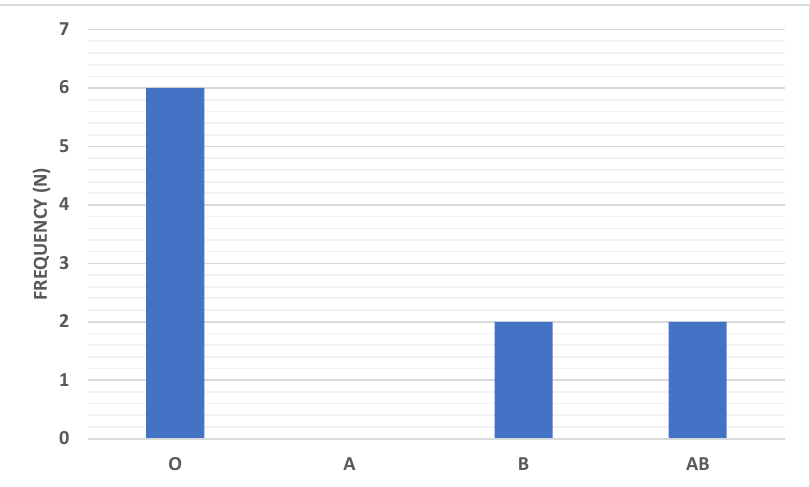
Figure 5. Distribution of the oxygen saturation percentage among COVID-19 patients according to the ABO blood group type. Data were presented as frequency (number). The artificial respiration distribution among COVID-19 patients according to the ABO blood group type is shown in Table 2 and Figure 6. Among the different blood groups, the blood group O showed the highest percentage of patients (2.9%) who required artificial respiration (standardized residuals of 1.9 and Bonferroni corrected p -value = 0.05). On the other hand, patients with blood group A showed the lowest percentage of patients (0%) who required artificial respiration (standardized residuals of 1.89 and Bonferroni corrected p -value = 0.05).